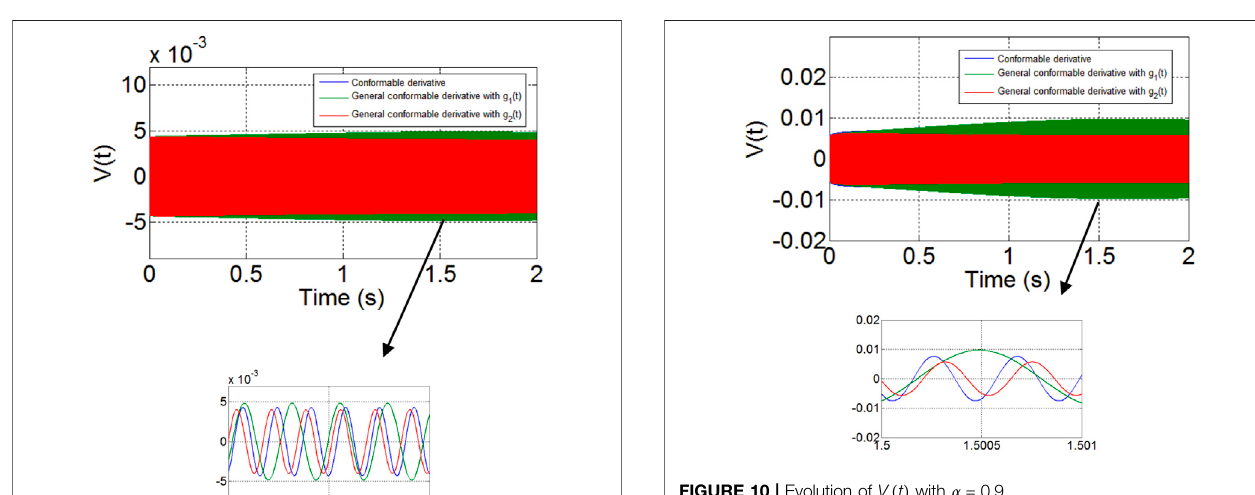
FIGURE 10 | Evolution of V ( t ) with α (cid:2) 0 . 9.